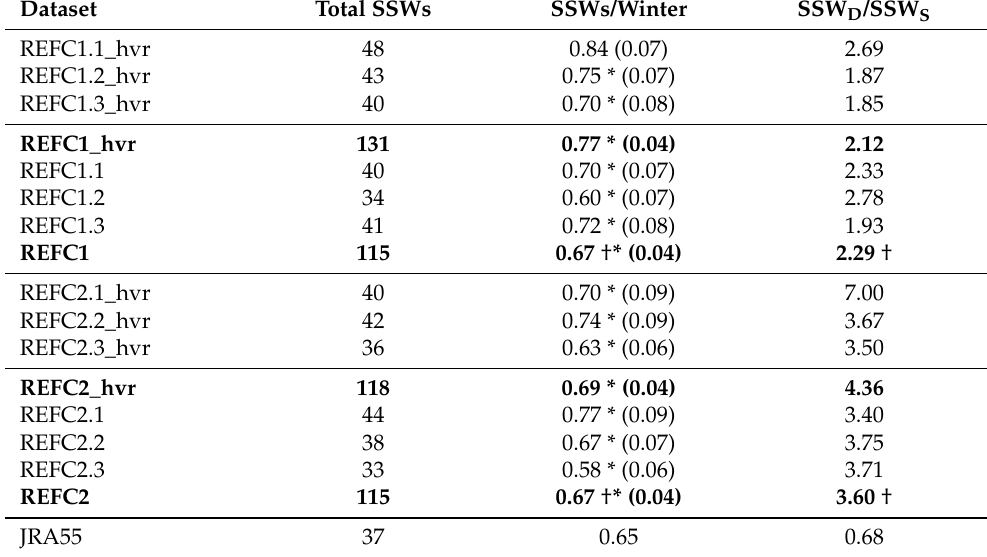
Table 1. SSWs climatology in WACCM4. Total number of major SSW events; Frequency of SSWs per winter (standard errors); SSW D /SSW S ratio for winter. The * indicates no significant differences at p < 0.05 with respect to JRA55 and † indicates no significant differences at p < 0.05 compared to the high vertical resolution